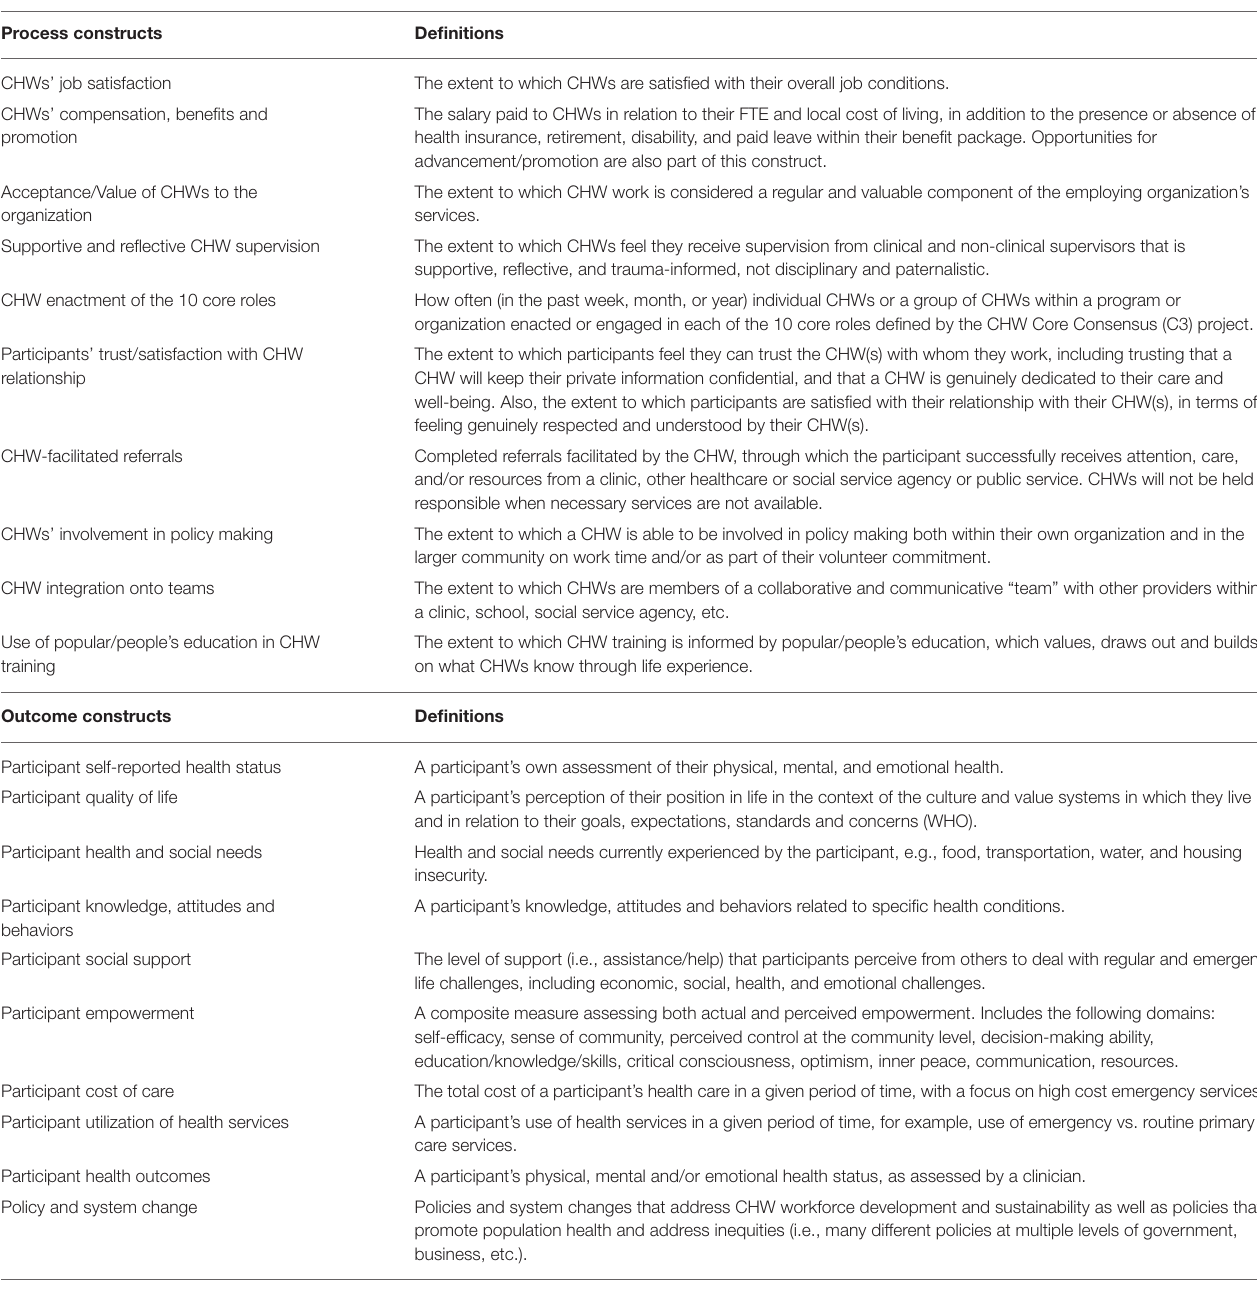
TABLE 1 | Full list of recommended constructs with